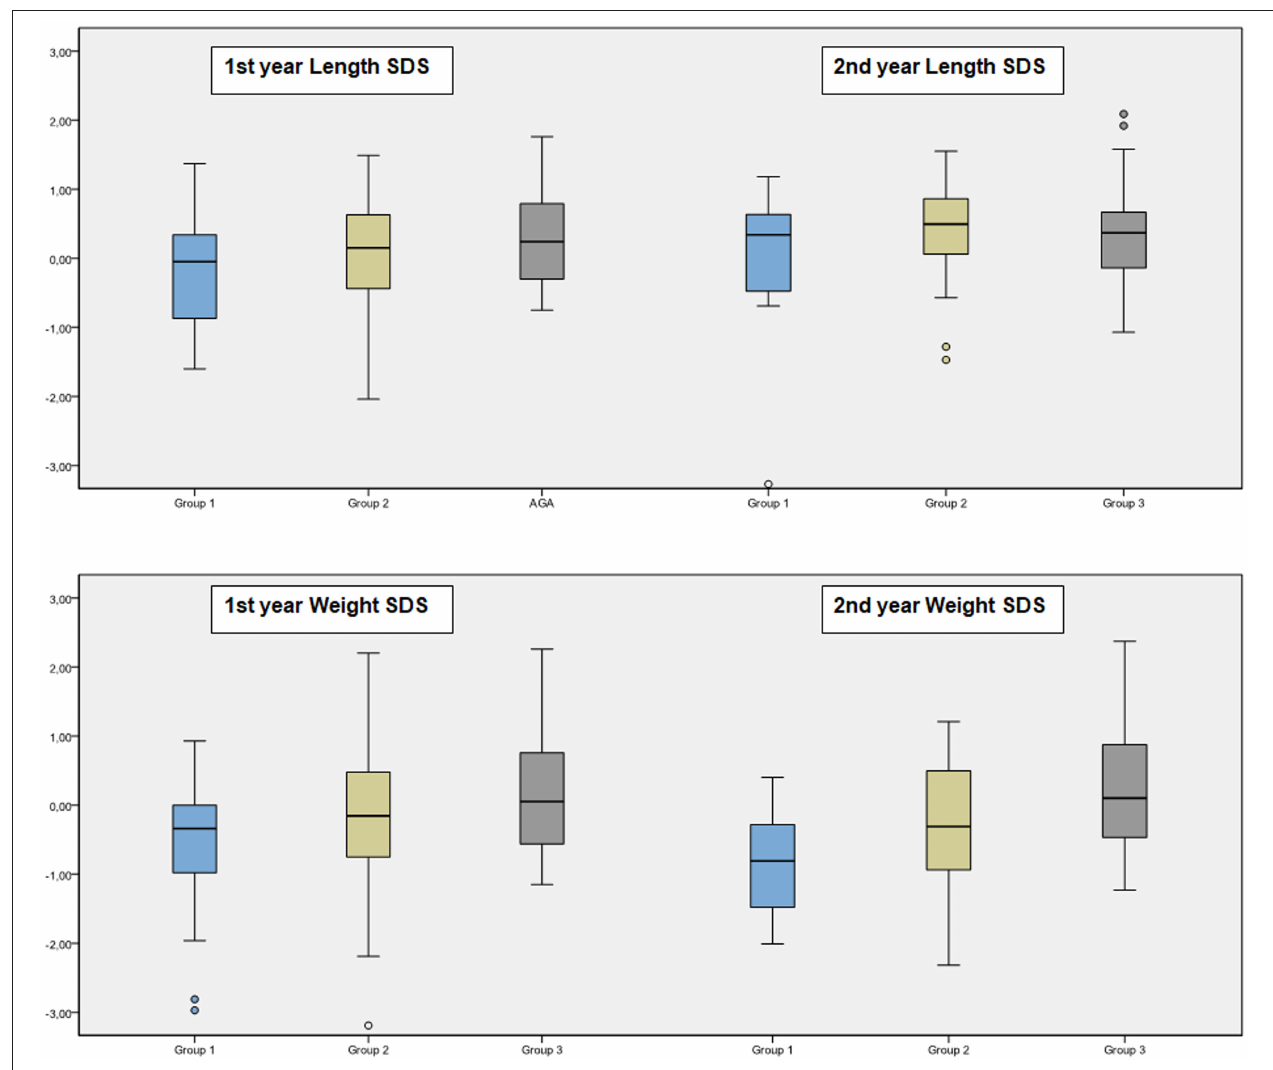
FIGURE 3 | Comparison of weight and length SDs of the groups.